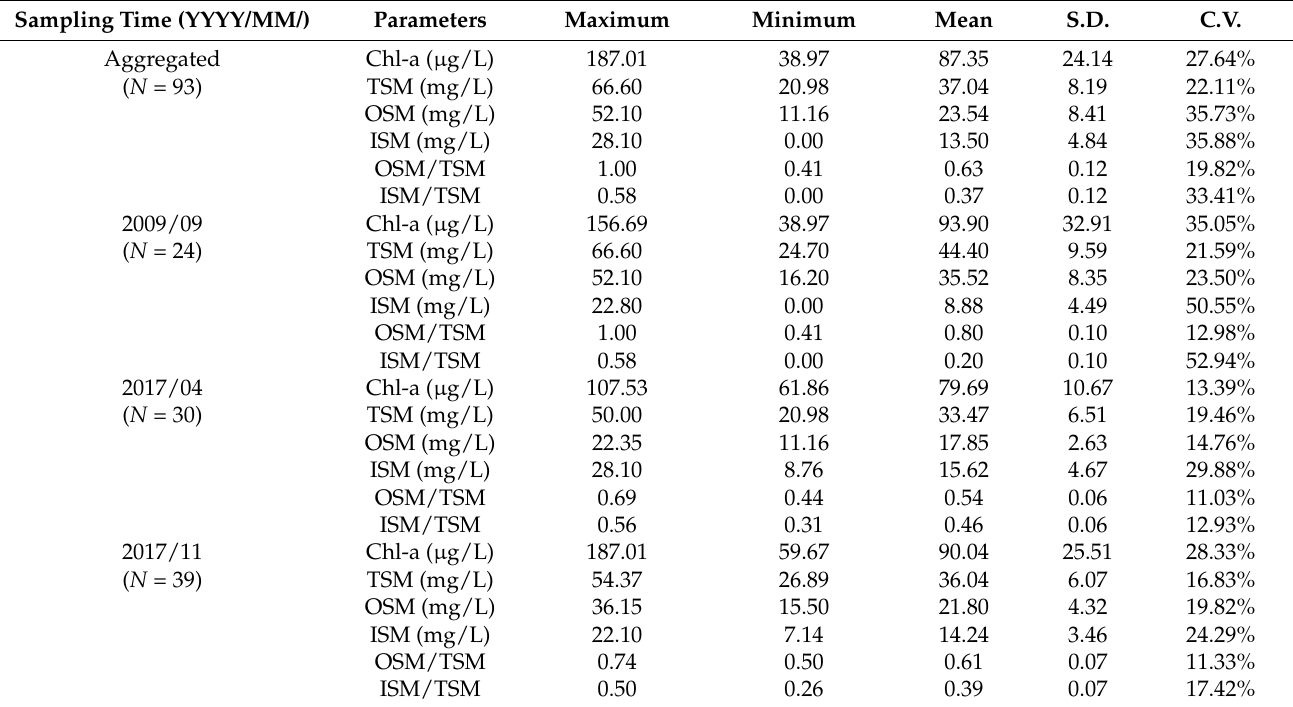
Table 2. Statistics of the water quality parameters measured for Chl-a concentration (Chl-a, µ g/L), total suspended matter concentrations (TSM, mg/L), organic suspended matter concentrations (OSM, mg/L), and inorganic suspended matter concentrations (ISM, mg/L) from Dianchi Lake. S.D. represents the standard deviation (mg/L), and C.V. represents the coefficient of variation